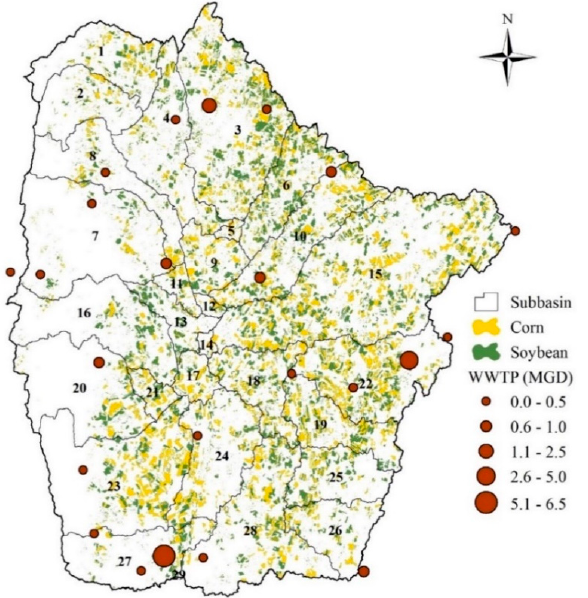
Figure 6. Location of WWTPs, and corn and soybean acreage within the watershed. Size of the point shows the capacity of the WWTP. Table 5. Estimated area of corn and soybean (in km 2 ) where reclaimed wastewater can be applied from neighboring WWTPs. A list of existing publicly owned WWTPs is included with their capac- ity and discharge method information.